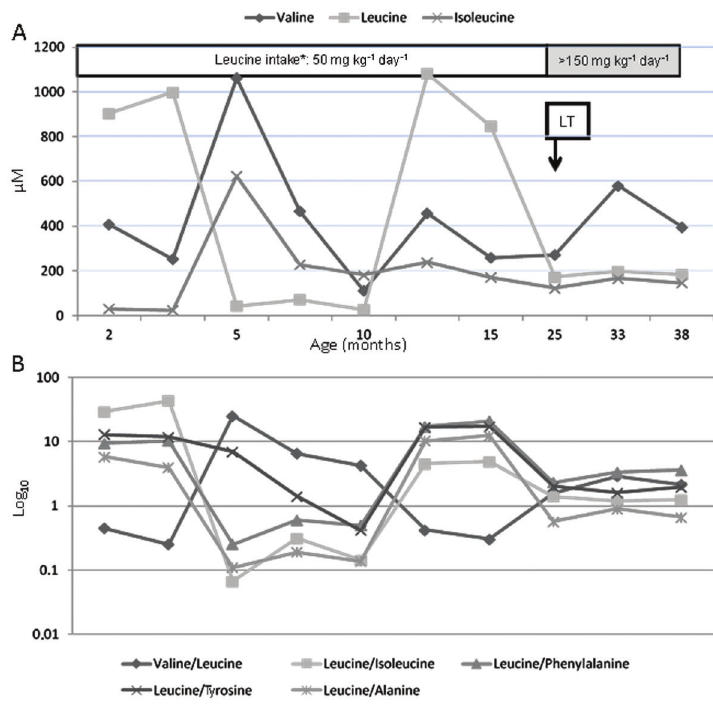
Figure 1. A , Pre- and post-transplantation branched-chain amino acid (BCAA) levels of the recipient with maple syrup urine disease. B , Molar relationship between BCAAs (log 10 ). LT: liver